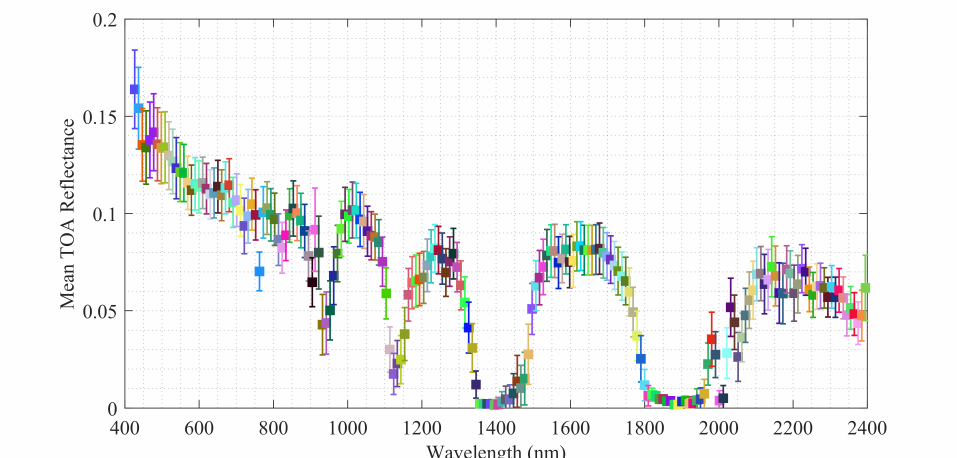
Figure A1. EO-1 Hyperion TOA reflectance mean and standard deviation of 64 images with respect to 196